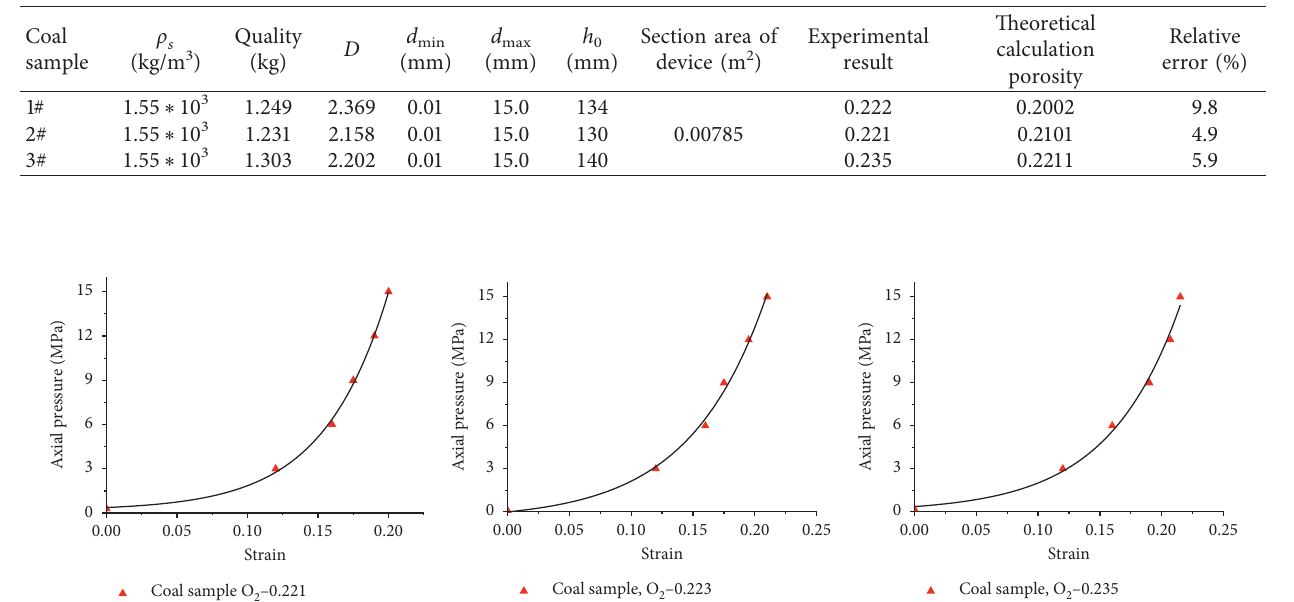
Table 2: The fractal dimension and porosity of the initial coal sample.